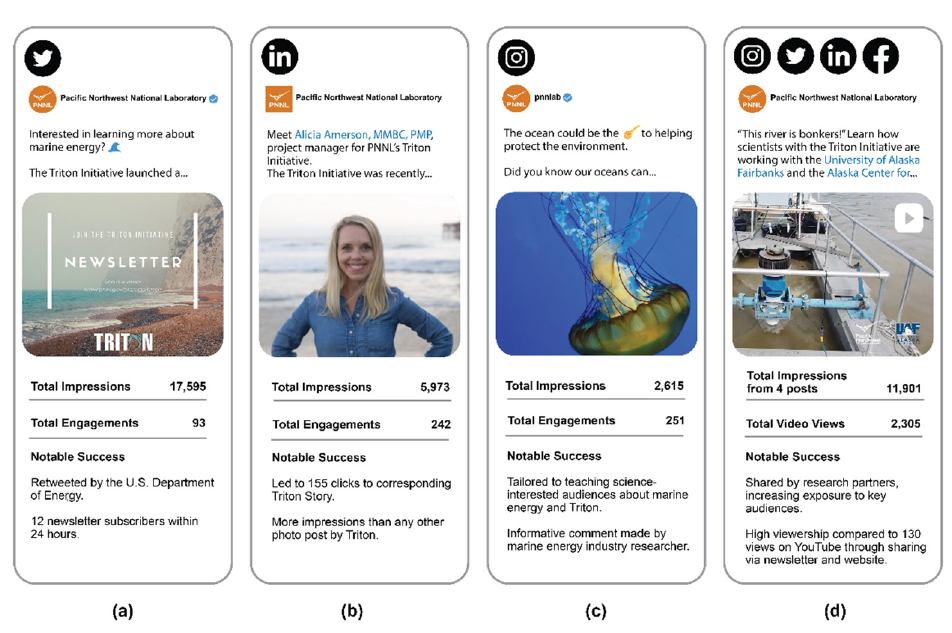
Figure 2. Examples of social media posts curated by Triton, including ( a ) a Twitter post promoting the Triton newsletter; ( b ) a LinkedIn post featuring a Triton team member and Triton Story; ( c ) an informational Instagram post about marine energy; and ( d ) a partner video highlighting TFiT field research shared on Instagram, Twitter, LinkedIn, and Facebook. Data compiled from each social media platform through SproutSocial.